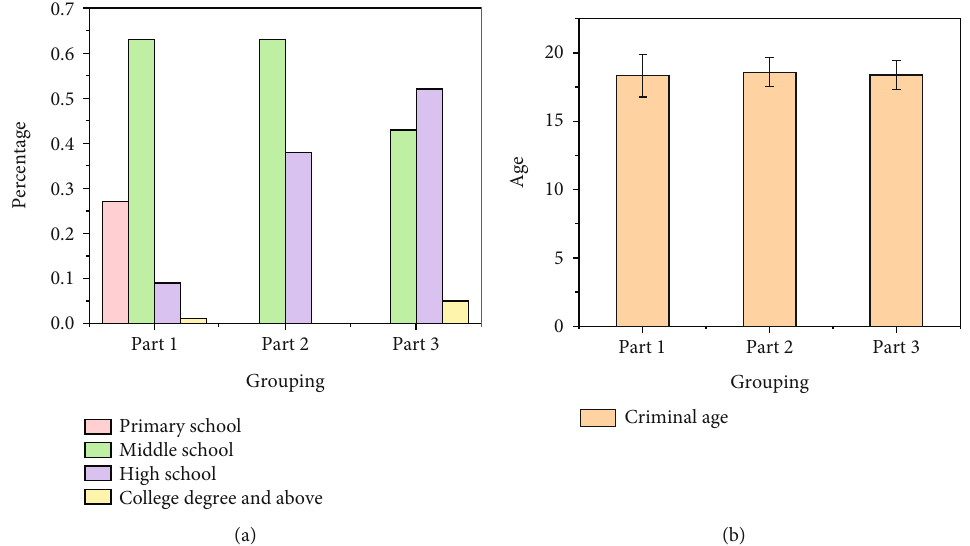
Figure 1: General statistics of di ff erent groups of adolescents ((a) education and (b) age).